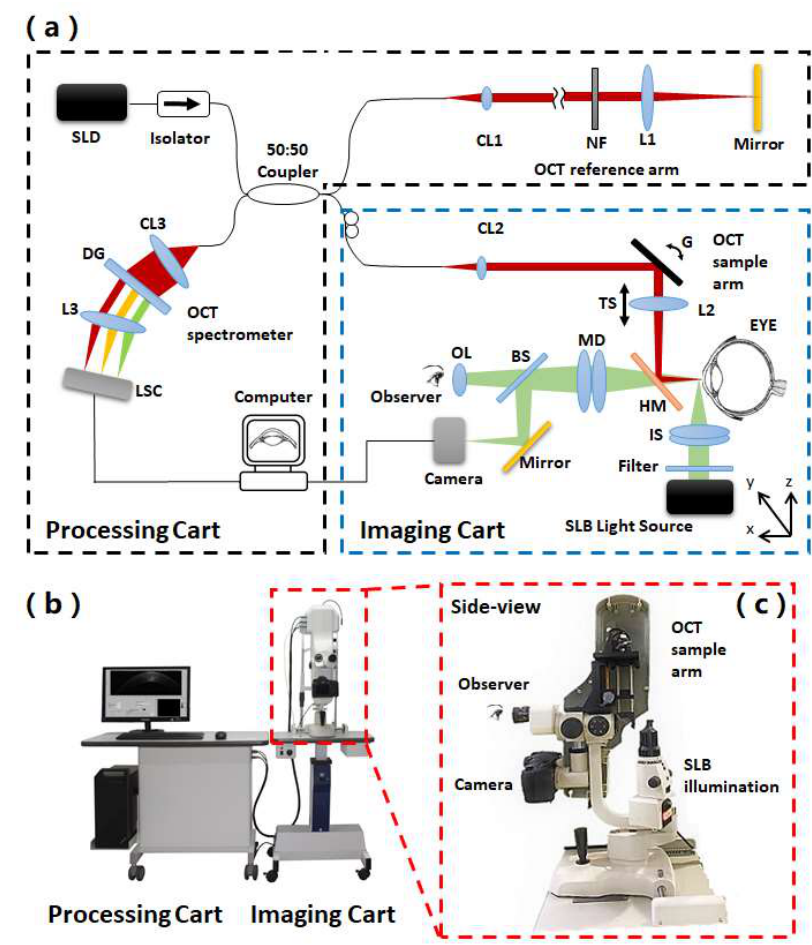
Figure 1. Schematic and photo of the multi-modal anterior eye imager. ( a ) Schematic of the system, SLD: superluminescent diode, CL: collimator, NF: neutral-density filter, L: lens, G: galvano, TS: translational stage, DG: di ff raction grating, LSC: line scanning camera, HM: hot mirror, IS: illumination shaper, BS: beam splitter, MD: magnification dial, OL: ocular lens. The UHR-OCT beam is depicted in red; the microvascular imaging module and SLB beam are depicted in green. Black dashed line-framed parts are installed on the processing cart, while blue dashed line-framed parts are installed on the imaging cart. ( b ) Photo of the system and ( c ) the side-view of the zoom-in